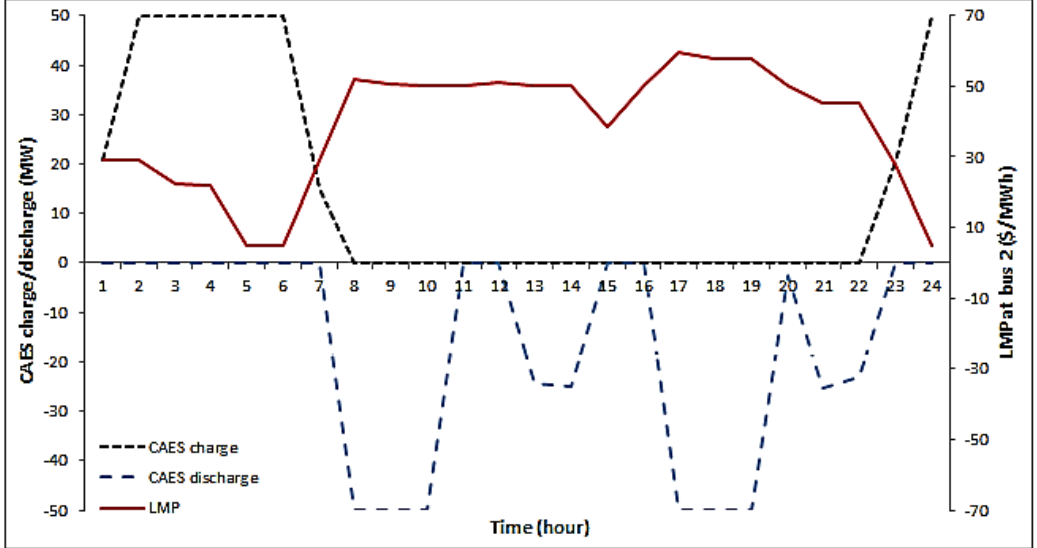
Figure 8. CAES DA charge/discharge schedule and DA LMPs at bus 2 under scenario 2.